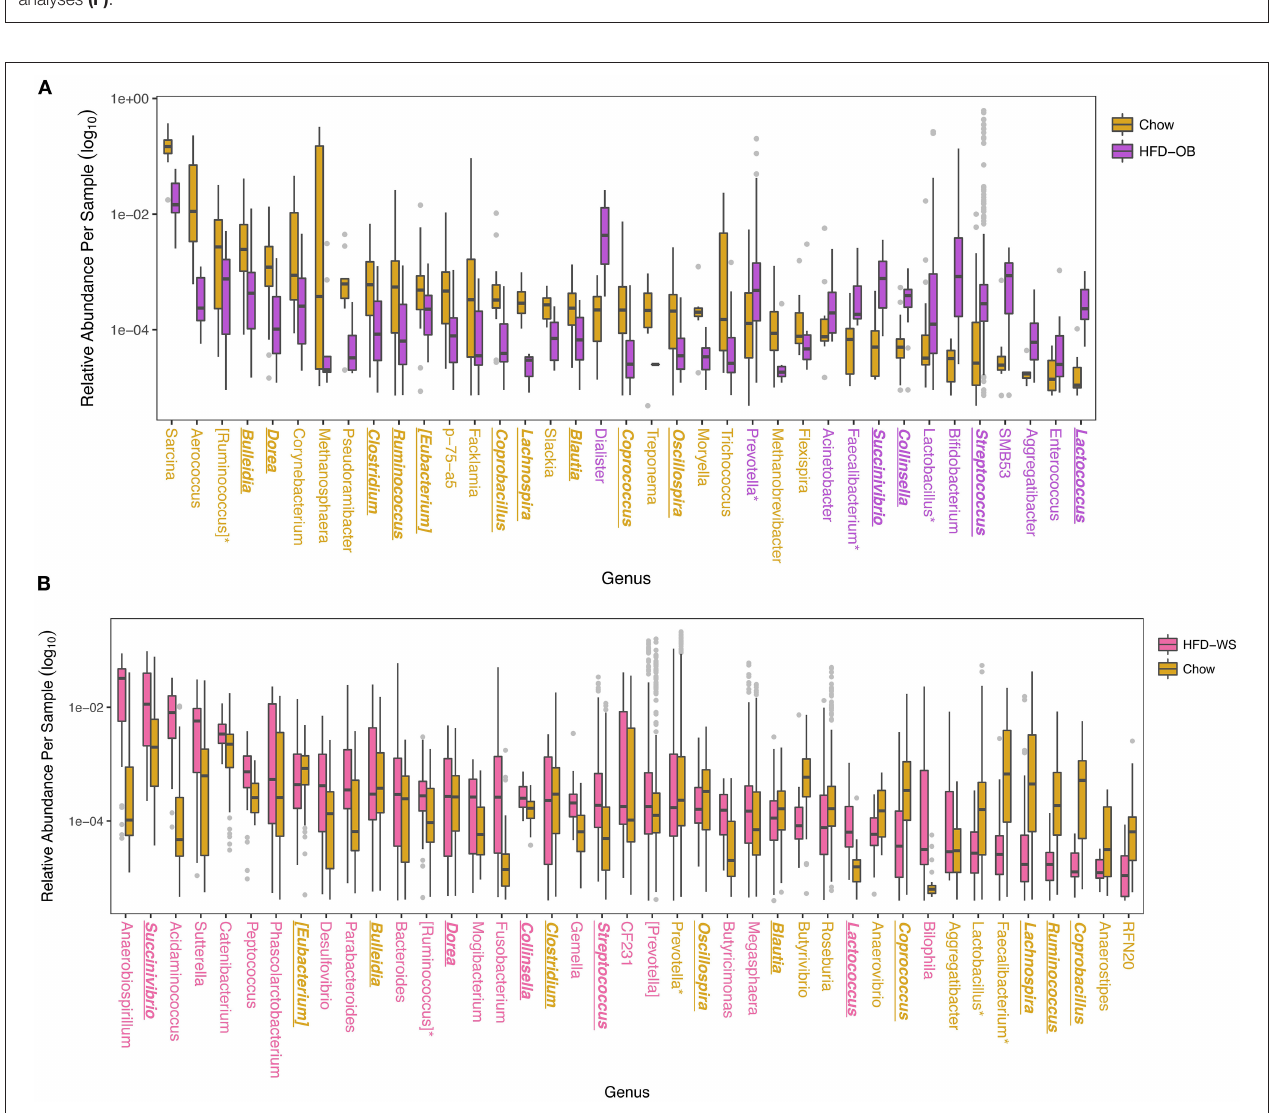
FIGURE 2 | centroid. Microbiome characteristics of alpha diversity (Shannon) and Firmicutes/Bacteroidetes Ratio (log 2 ) were tested with Mann Whitney non-parametric t -test (C) or non-parametric Kruskal-Wallis ANOVA (D) . Differentially abundant phyla between diets were determined by DESeq2 using age and treatment as covariates and are bolded and italicized (E) . The two chow time points were combined for the RA study and time was added as a covariate in analyses (F)